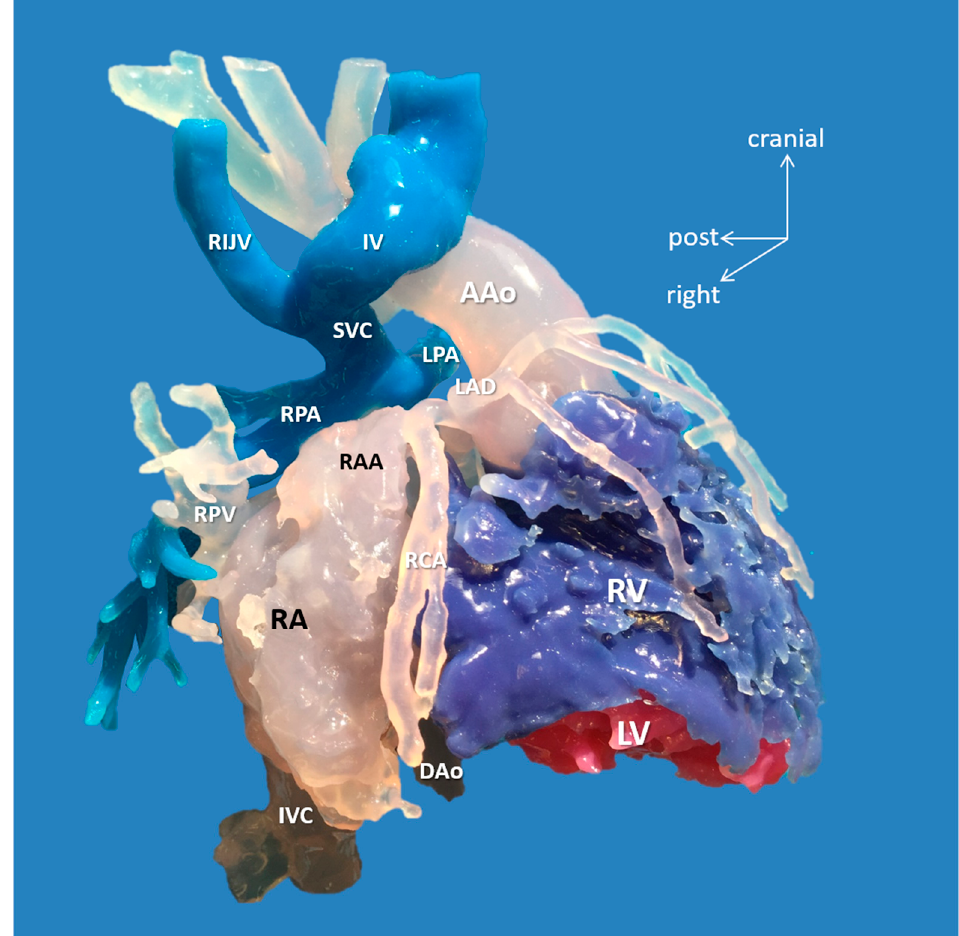
Figure 3. 3D-printed blood volume model of mesocardia, common atrium, criss-cross heart (supero-inferior ventricles), transposition of the great arteries, and pulmonary atresia, restrictive VSD and thrombus formation in the left ventricle; operated bidirectional superior cavopulmonary (Glenn) anastomosis (Case 15). Patient also had variant coronary artery anatomy: right coronary and left anterior descending arteries originated from left-hand facing posterior sinus, and a separate circumflex originated from right-hand facing anterior sinus. Modeling was indicated to assess the extent of the left ventricle thrombus and suitability for biventricular repair. The model did not reveal any possibility of connecting the left ventricle to the aorta. Patient underwent univentricular staging: total cavopulmonary connection with intracardiac conduit, LV thrombus removal and VSD enlargement. Abbreviations: AAo: ascending aorta, DAo: descending aorta, IV: innominate vein, IVC: inferior vena cava, LAD: left anterior descending coronary artery, LPA: left pulmonary artery, LV: left ventricle, RA: right atrium, RAA: right atrial appendage, RCA: right coronary artery, RIJV: right internal jugular vein, RPA: right pulmonary artery, RPV: right pulmonary vein, RV: right ventricle, SVC: superior vena cava.